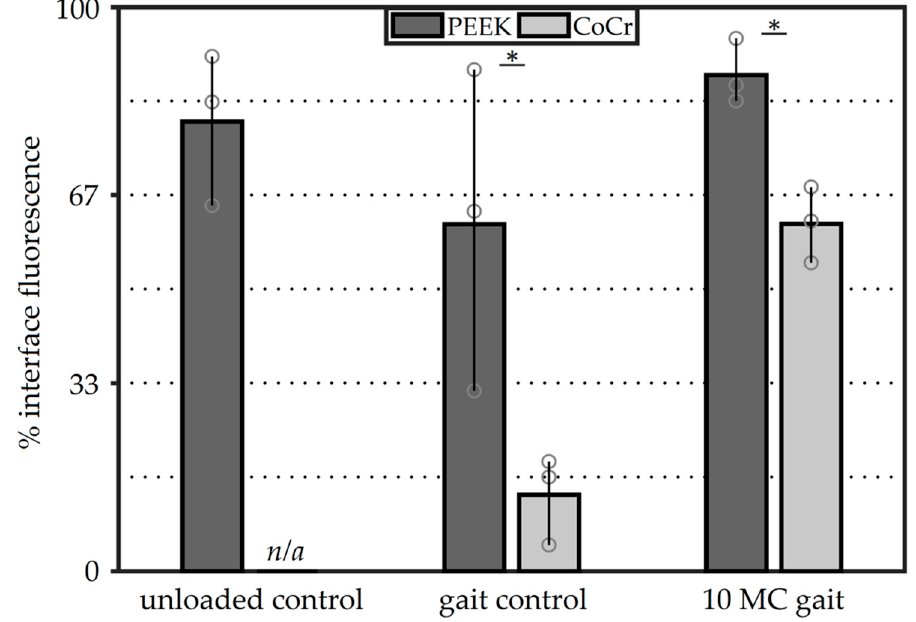
Figure 5. Average interface fluorescence scores of the complete implant–cement interfaces at difference intervals. The bars show the range of observations with the individual specimens shown as circles (statistical analysis compares PEEK to CoCr; * denotes p < 0.05).